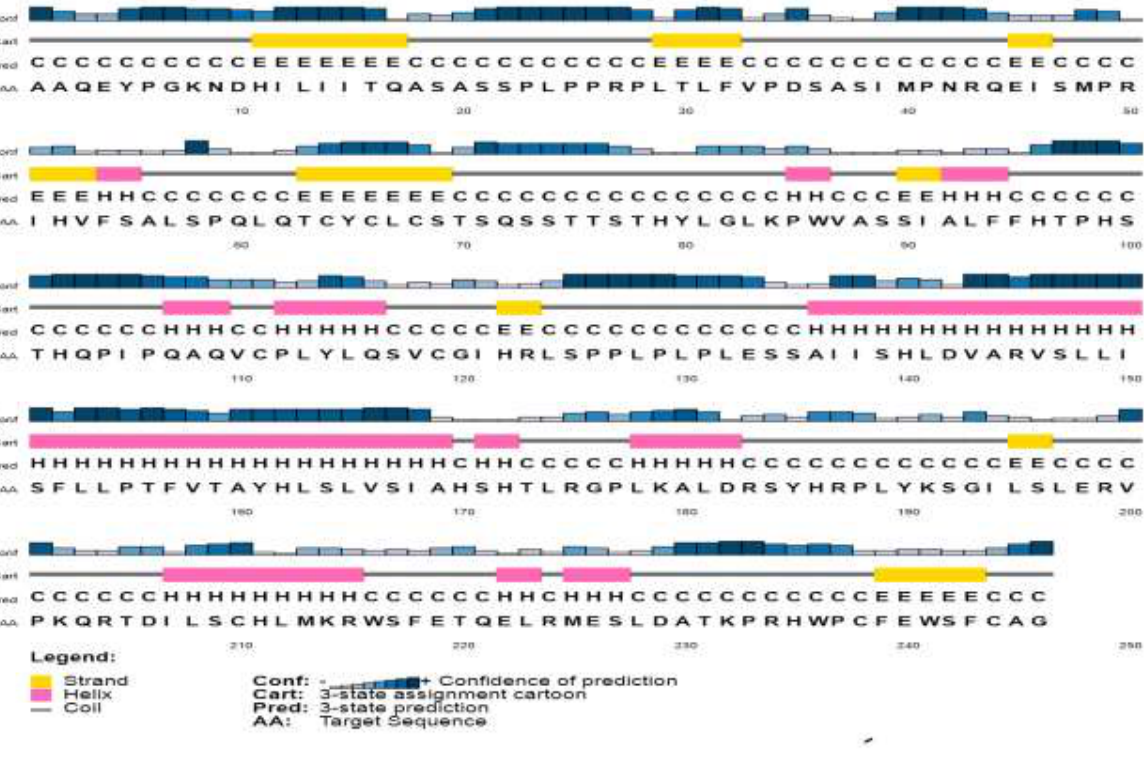
Figure 4: The secondary st ructure of TCF7L2 in T2DM Iraqi